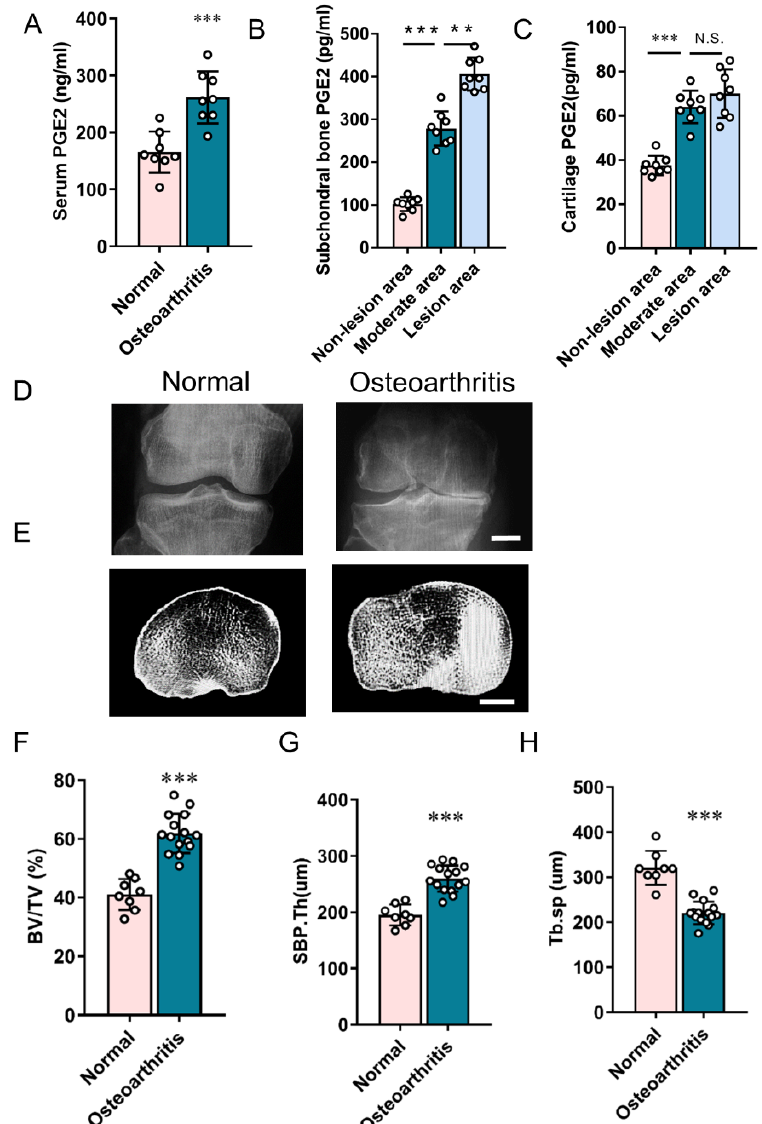
Figure 2. Increased PGE2 levels and aberrant subchondral bone architecture occur in human osteoarthritis. ( A – C ) ELISA quantitative analysis of PGE2 concentration in the serum ( A ), subchondral bone ( B ), and articular cartilage ( C ) in humans. ( D ) X-ray images of the knee joint (anteroposterior view) in normal and osteoarthritis humans. Scale bar: 20 mm. ( E ) Representative HR-QCT images (horizontal view) of tibial subchondral bone in normal and osteoarthritis humans. Scale bar: 20 mm. ( F – H ) Quantitative analysis of subchondral bone structure parameters: BV/TV ( F ), Tb.Sp ( G ),